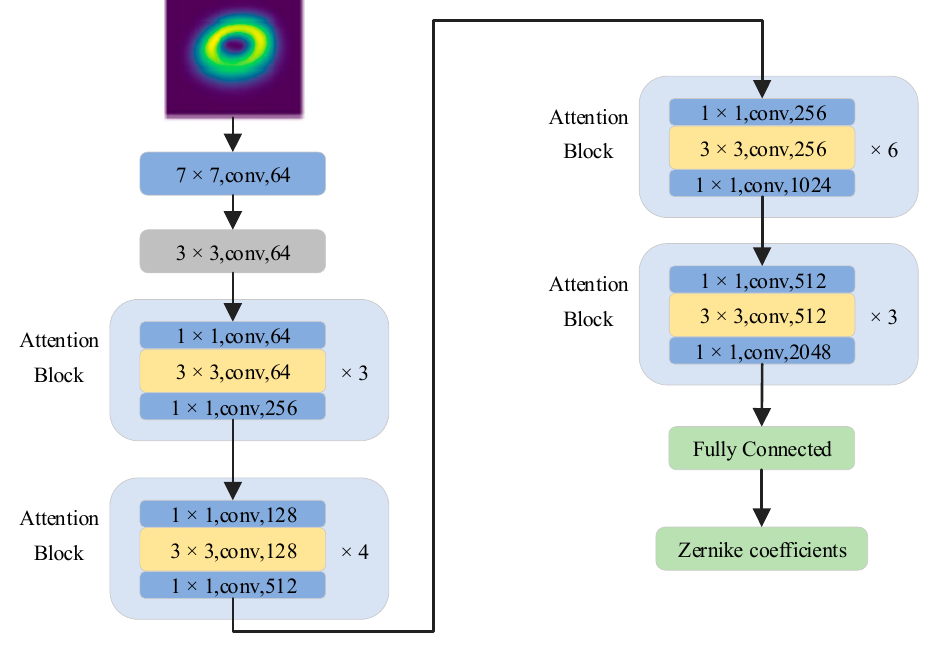
Figure 2. Overall network structure.